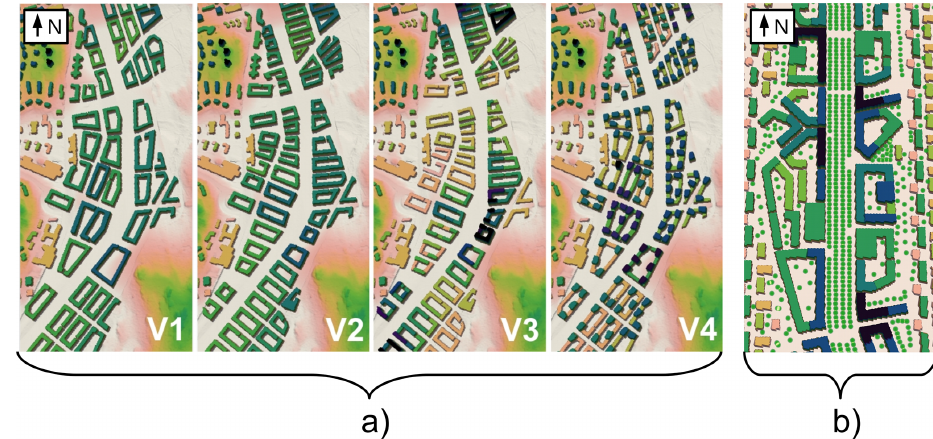
Figure 1. Simulation domains of the LES output data applied in the study: (a) four city-planning alternatives (V1–V4) investigated in KU18 (Kurppa et al., 2018) and (b) city-boulevard scenario S1 and its surroundings studied in KA20 (Karttunen et al., 2020). Green dots illustrate trees. The city boulevard is 54 and 58m wide in KU18 and KA20,